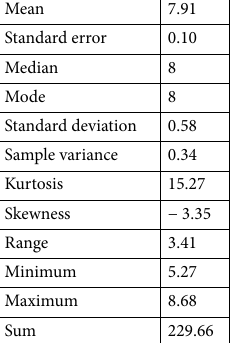
Table 1. Descriptive analysis of the observed dissolved oxygen